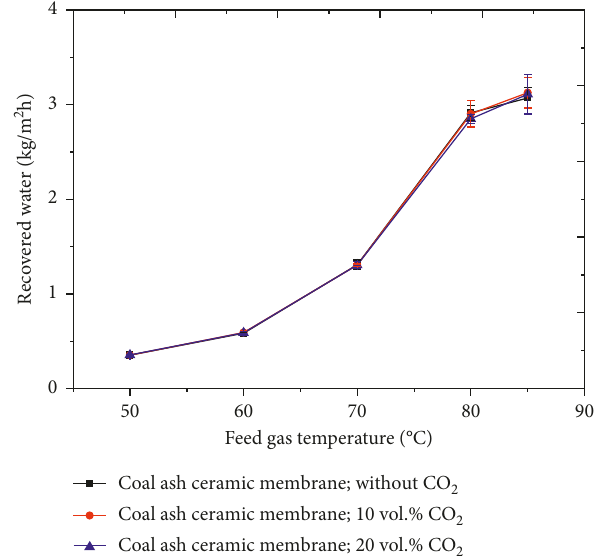
Figure 8: The influence of CO